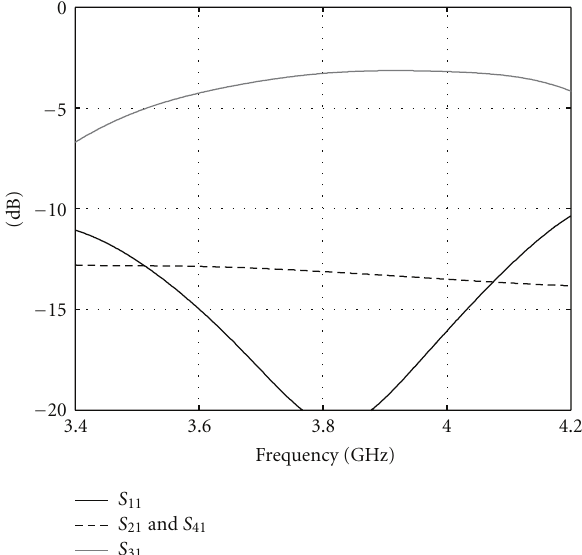
Figure 3: Coupling between the feed points of the low-profile EBG antenna without the distribution circuit when the feed point 1 is fed and the others loaded on 50 ohm.